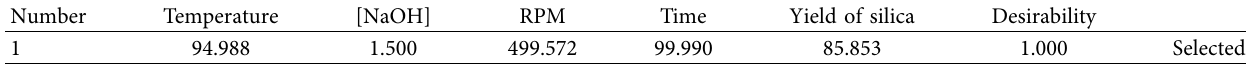
Table 7: The optimum yield was obtained.